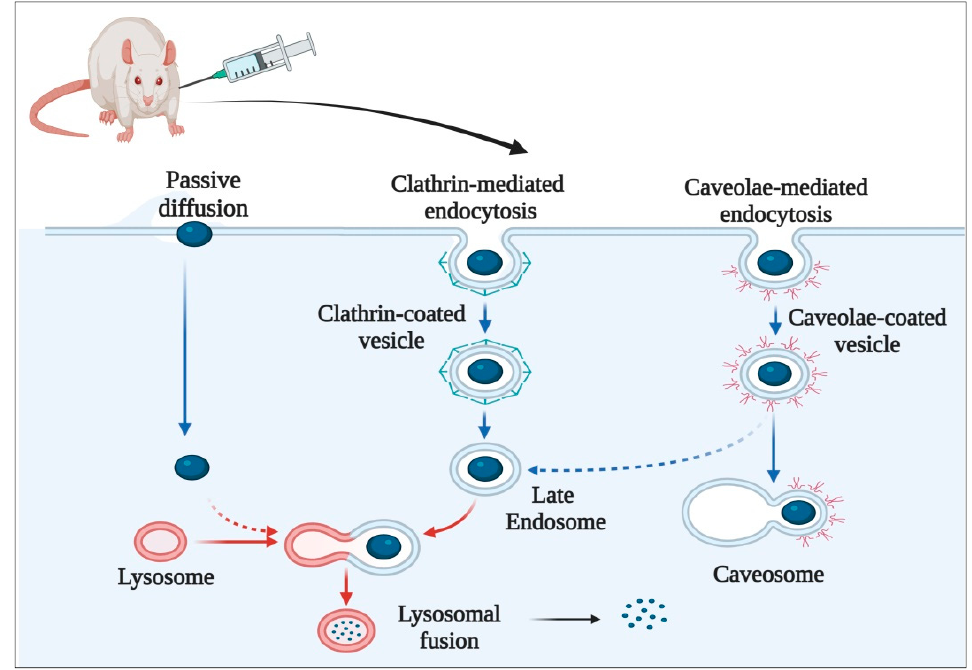
Figure 3. Major cellular pathways for internalization of carbon nanostructures.